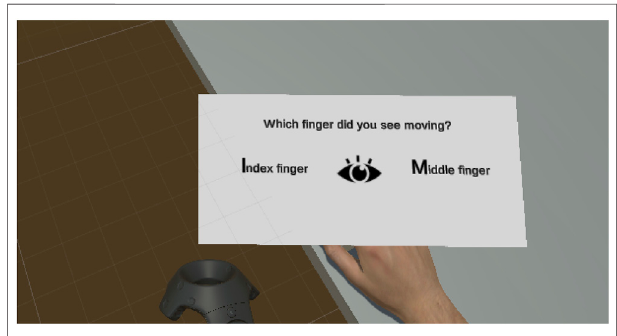
FIGURE 4 | Visual perception question